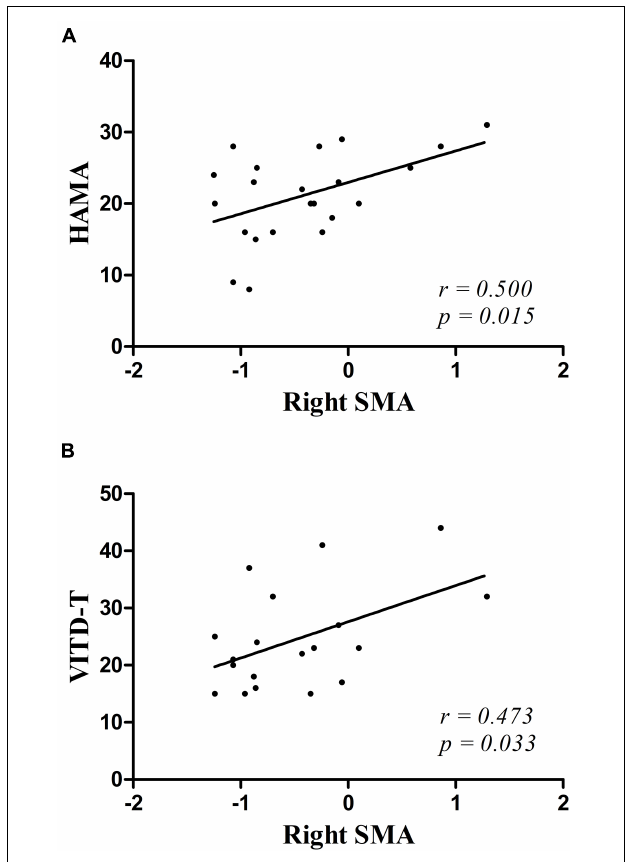
FIGURE 2 | (A,B) Positive correlations were observed between the GFC values in the right SMA and the scores of HAMA and the vitamin D in patients with MDD. HAMA, Hamilton Anxiety Scale; VITD-T, vitamin